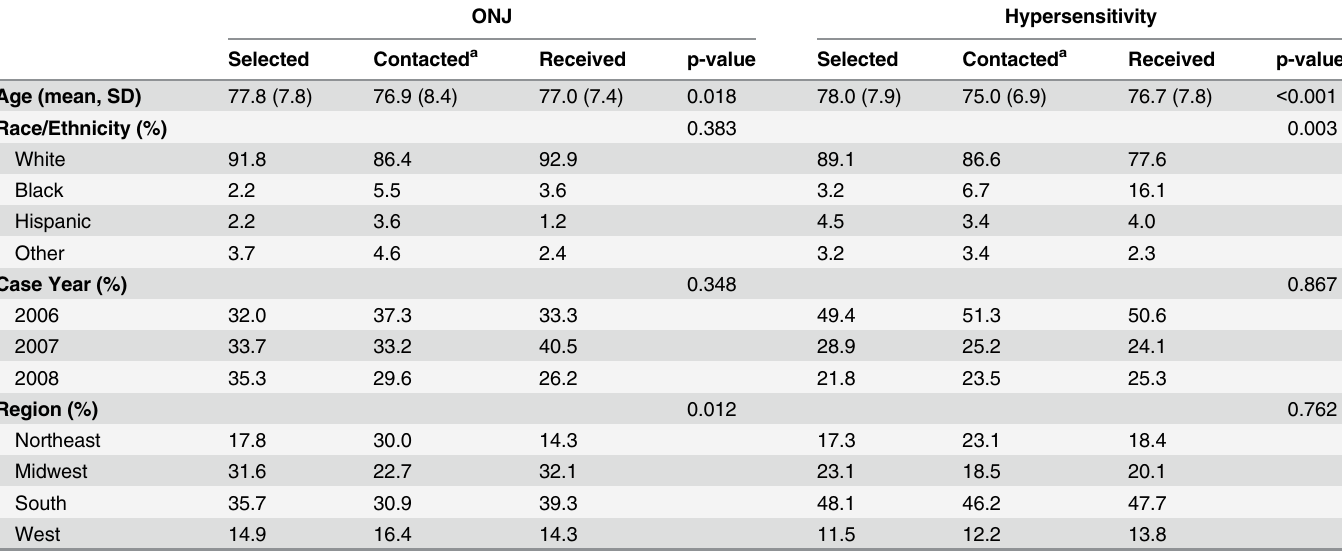
Table 3. Characteristics of Potential Cases by Contact